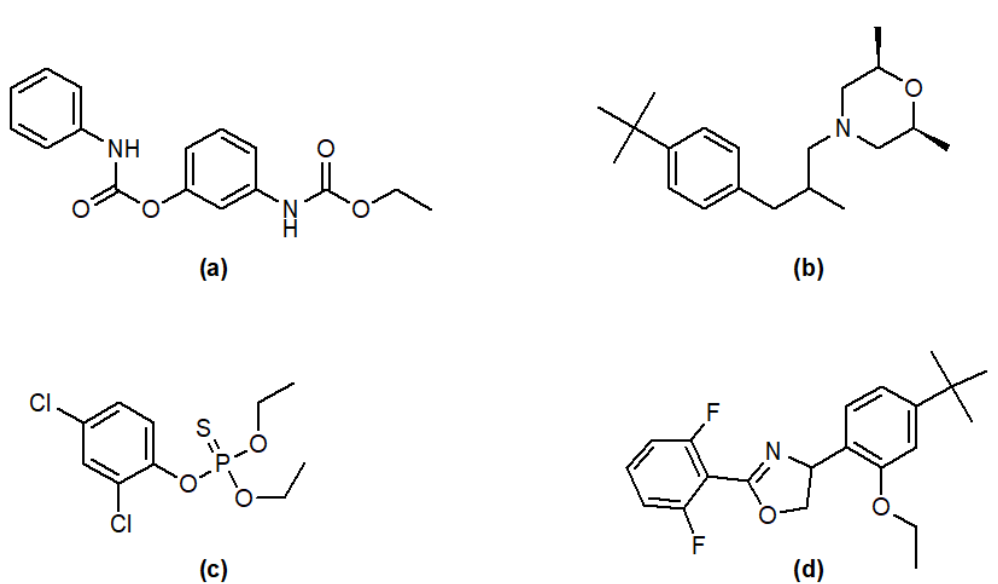
Figure 3. Chemical Structure of pesticides detected in the propolis sample, ( a ) desmedipham, ( b ) fenpropomorph, ( c ) dichlofenthion and ( d ) etoxazole.